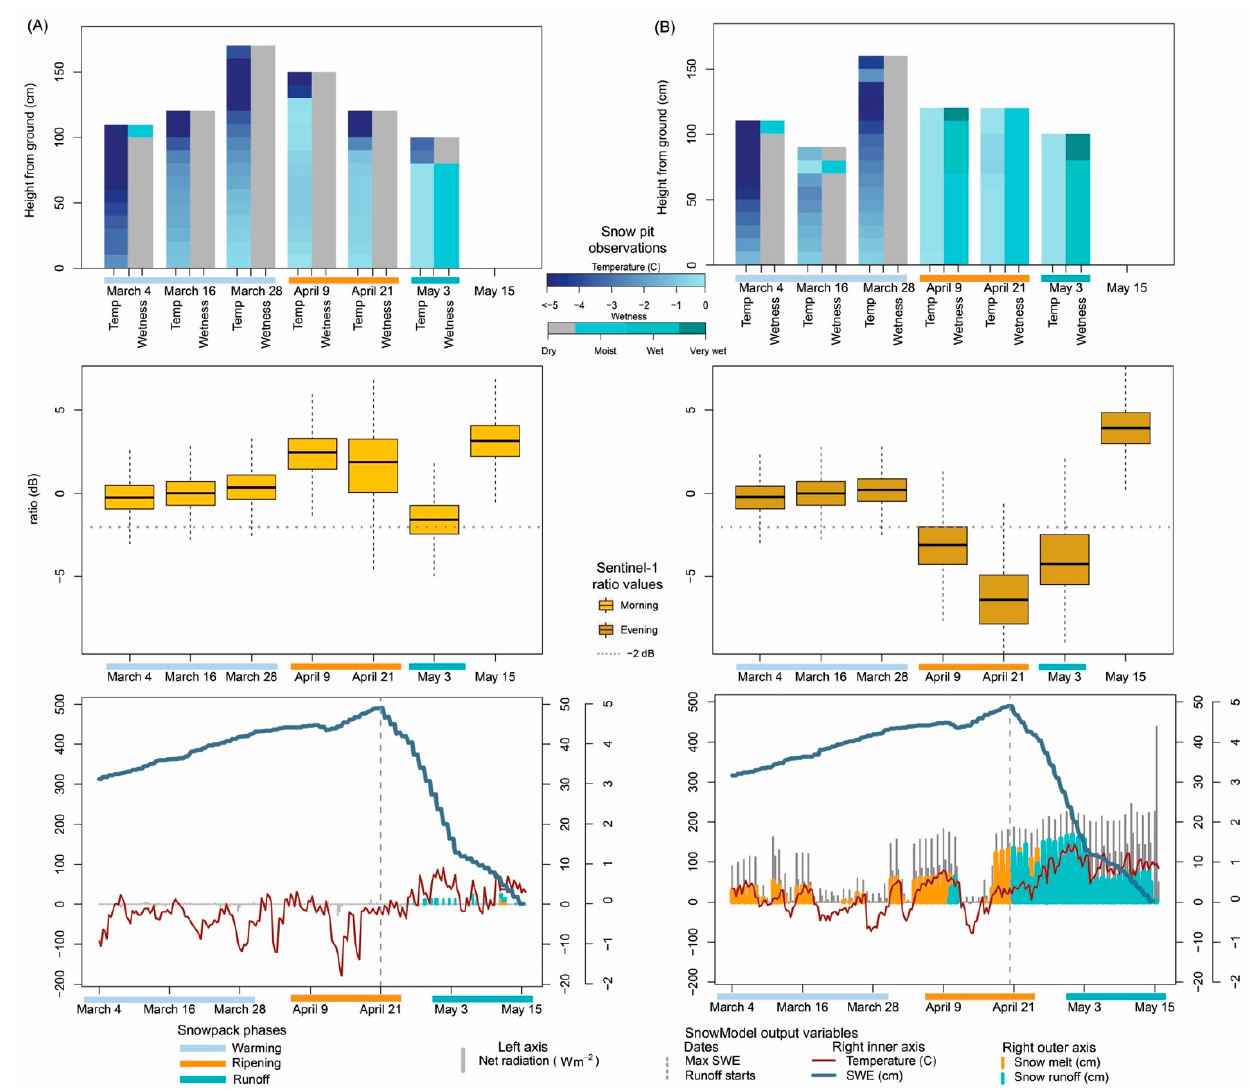
Figure 9. Snow conditions integration panel for ( A ) morning and ( B ) afternoon for in situ measure- ments of snowpack temperature and wetness ( top row ), Sentinel-1 ratio values ( middle row ), and SnowModel output variables ( bottom row ) for 4 March–15 May 2020, covering periods of field- measured snowpack warming, ripening, and runoff (highlighted with light blue, orange, and cyan).